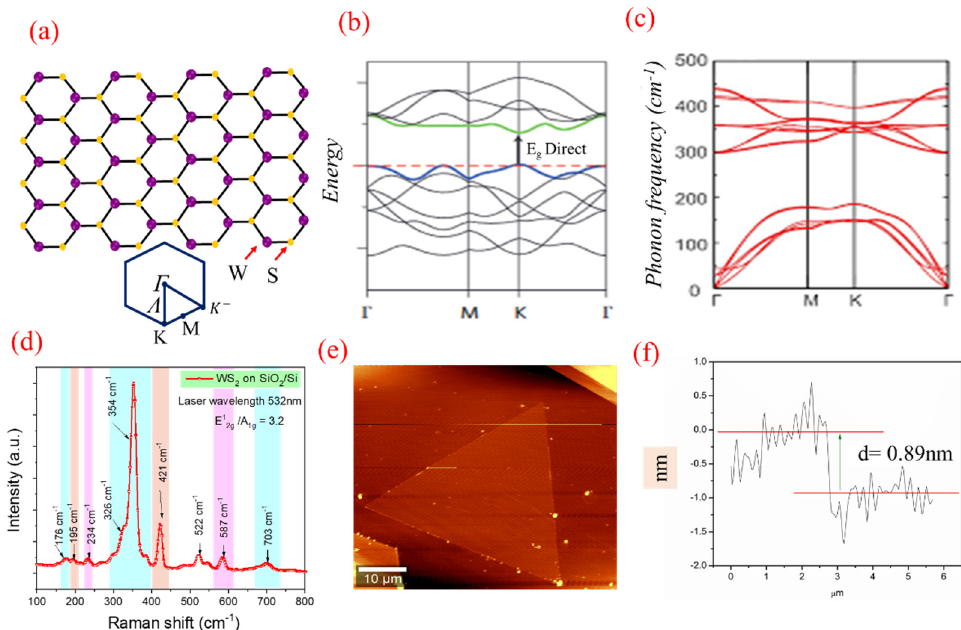
Figure 4. ( a ) Real space lattice structure and Brillouin zone in reciprocal space, ( b ) electronic band structure ( E-K diagram), ( c ) phonon dispersion, ( d ) Raman spectrum, ( e ) AFM image of WS 2 monolayer crystal grown on Si/SiO 2 substrate and ( f ) AFM cross-section height profile for the deposited sample revealing a thickness of the grown film to be ~0.89 nm.